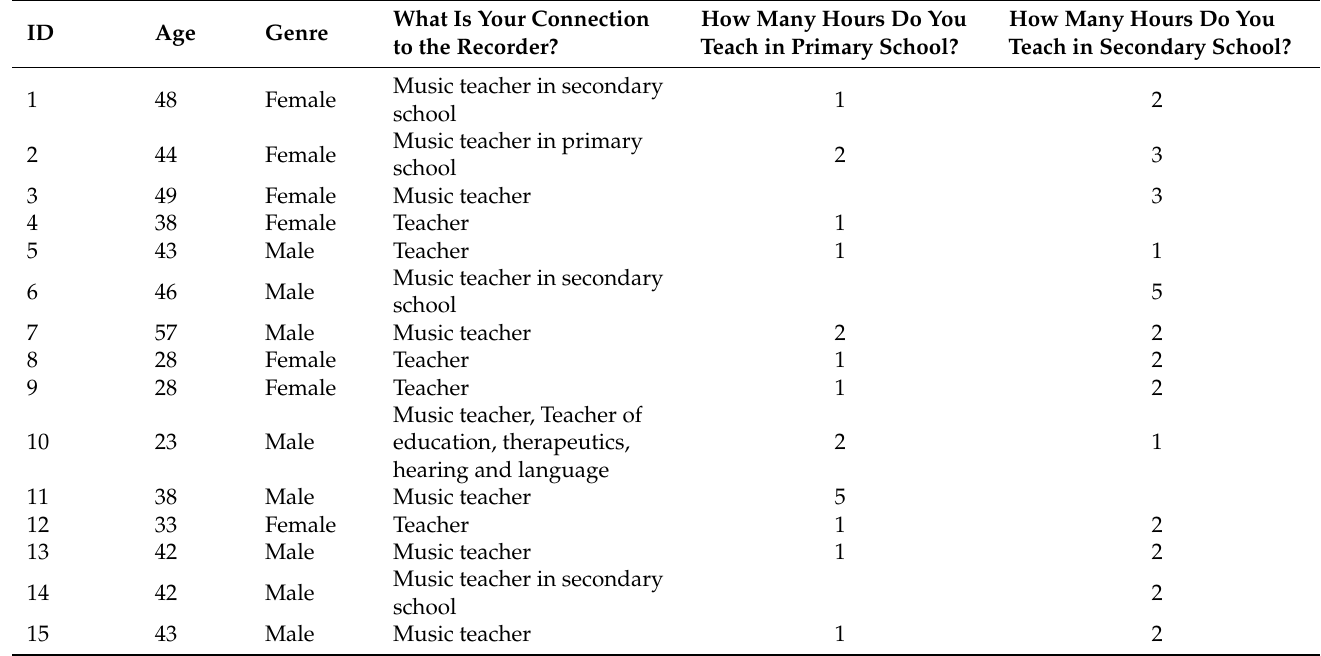
Table 4. List of experts in music at schools.